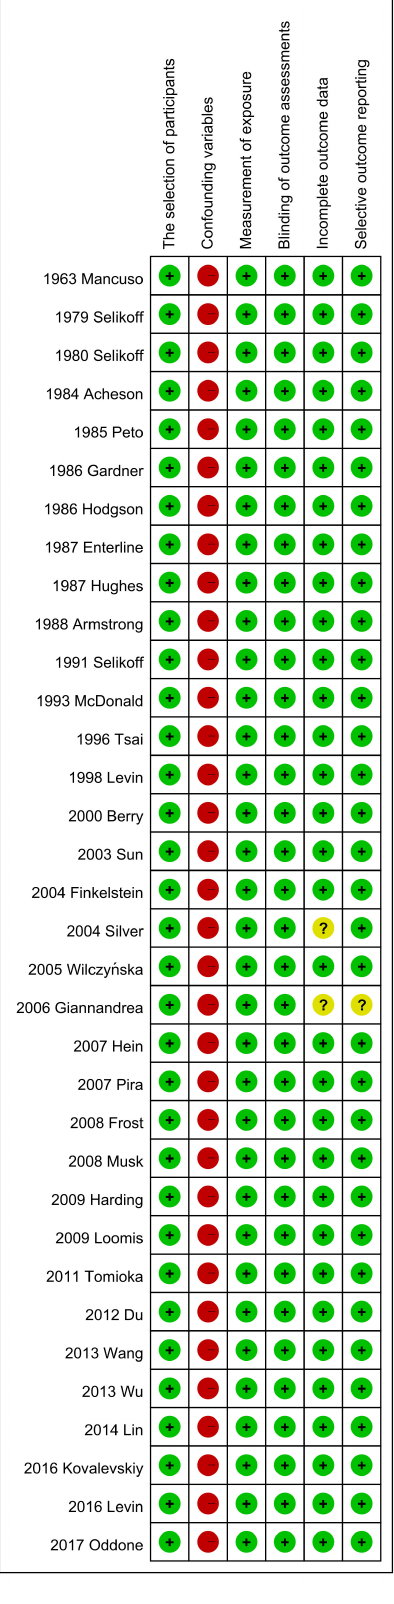
Figure 11. Graph summary of the Risk of Bias Assessment tool for Non-randomized Stud- ies